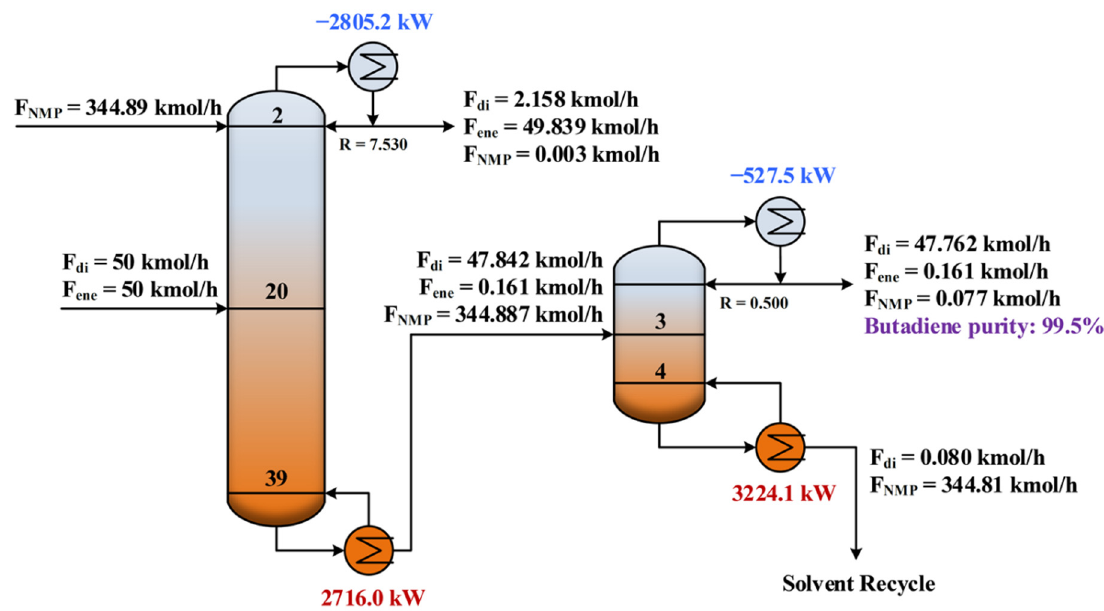
Figure 8. Optimal flowsheet of the ED process using NMP as entrainer.